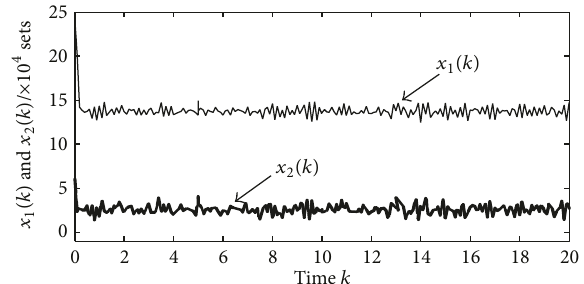
Figure 2: Fuzzy membership functions of inventory input variables.